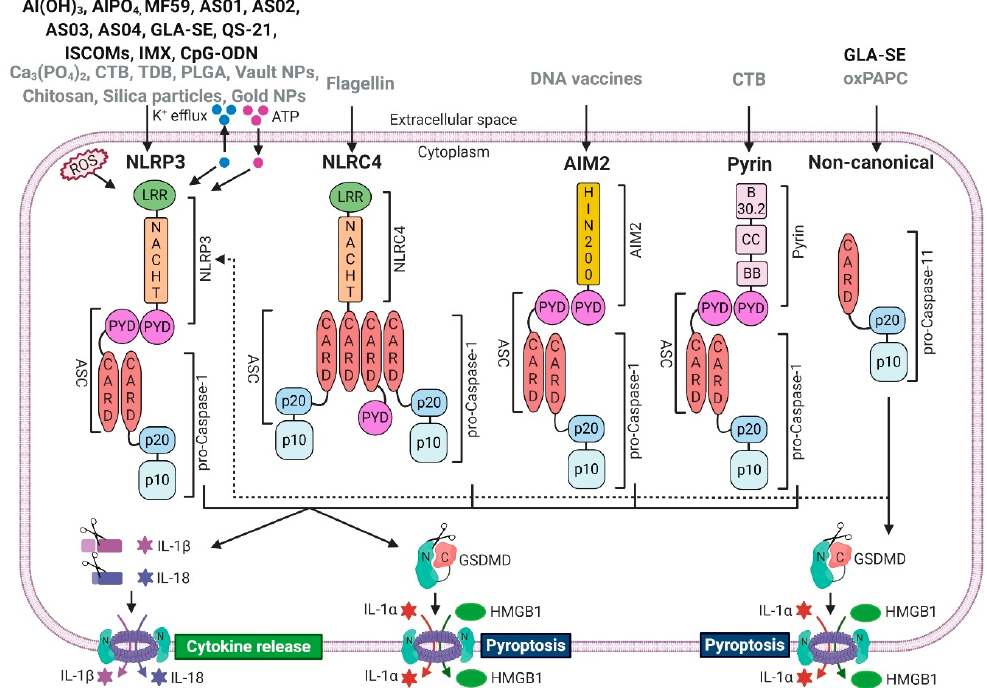
Figure 1. Vaccine adjuvants can activate inflammasomes. Clinically approved (black) and experimental (grey) vaccine adjuvants induce (or possibly induce) assembly and activation of canonical- (NLRP3, NLRC4, AIM2, Pyrin) and non-canonical (caspase-11 in mice, caspase-4/5 in humans) inflammasomes. Canonical inflammasomes recruit caspase-1 via the adaptor molecule ASC, which leads to proximity-induced auto-processing and activation of caspase-1, resulting in cleavage of pro-IL-1 β and pro-IL-18 as well as the secretion of their mature forms. Activated caspase-1 also cleaves and activates GSDMD, resulting in pore formation and pyroptosis, which mediates the release of pro-inflammatory DAMPs such as IL-1 α or HMGB1. Caspase-11 cleaves GSDMD and induces pyroptosis, but it does not process pro-IL-1 β or pro-IL-18. However, non-canonical inflammasomes activate the NLRP3 inflammasome, which indirectly induces the maturation and secretion of IL-1 β and IL-18 via the non-canonical route. Abbreviations: apoptosis-associated speck-like protein containing a CARD (ASC), caspase recruitment domain (CARD), pyrin domain (PYD), high-mobility group box 1 (HMGB1), leucine-rich repeat (LRR), domain present in NAIP, CIITA, HET-E, and TP1 (NACHT), gasdermin D (GSDMD), reactive oxygen species (ROS), adenosine triphosphate (ATP), coiled-coil (CC), exon B30.2 domain (B30.2), B-box-type zinc finger domain (BB); immunostimulating complex (ISCOM); ISCOMATRIX (IMX). Created with BioRender.com (Toronto,